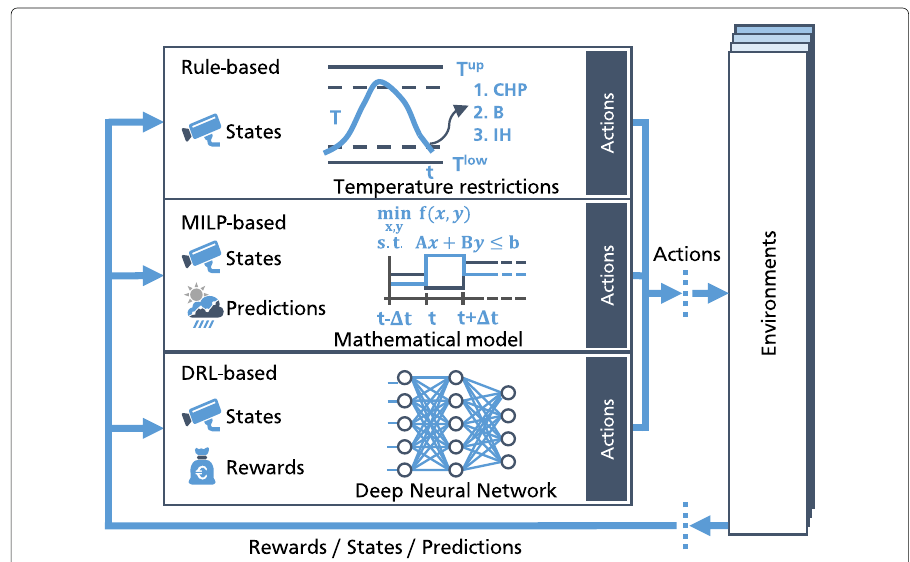
Fig. 4 Control algorithms. Within the framework, different algorithms (rule-based, MILP-based, DRL-based) are tested for the control of environments. The environments are simulations of the industrial energy supply systems to be controlled